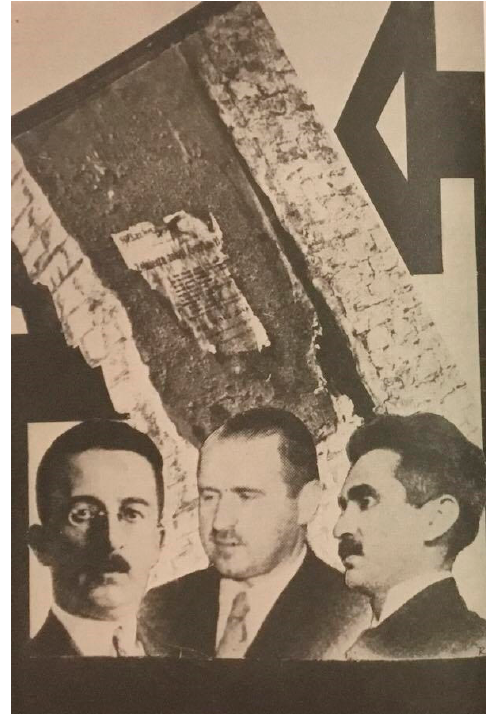
Figure 6. Teresa Ż arnower, The Defense of Warsaw photomontage: The leaders: Niedzia ł kowski, Figure 6. Teresa ˙Zarnower, The Defense of Warsaw photomontage: The leaders: Niedziałkowski, Starzy ń ski, Rataj, 1942, Muzeum Sztuki, Ł ód ź , public domain image. Starzy´nski, Rataj, 1942, Muzeum Sztuki, Ł ó d´z, public domain